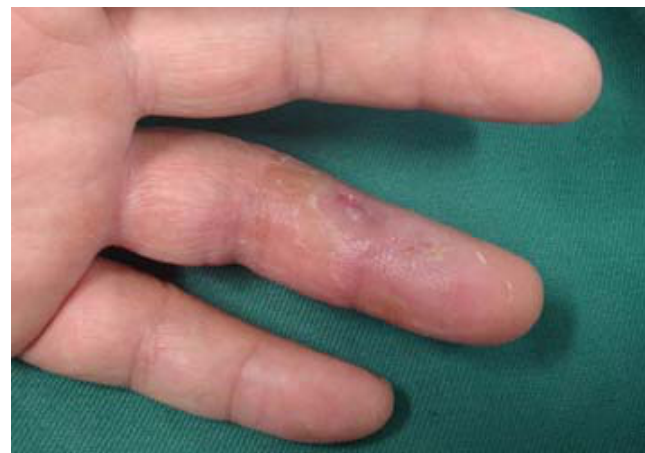
Figure 9. The wound healed with slight sensory disturbance within 1.5